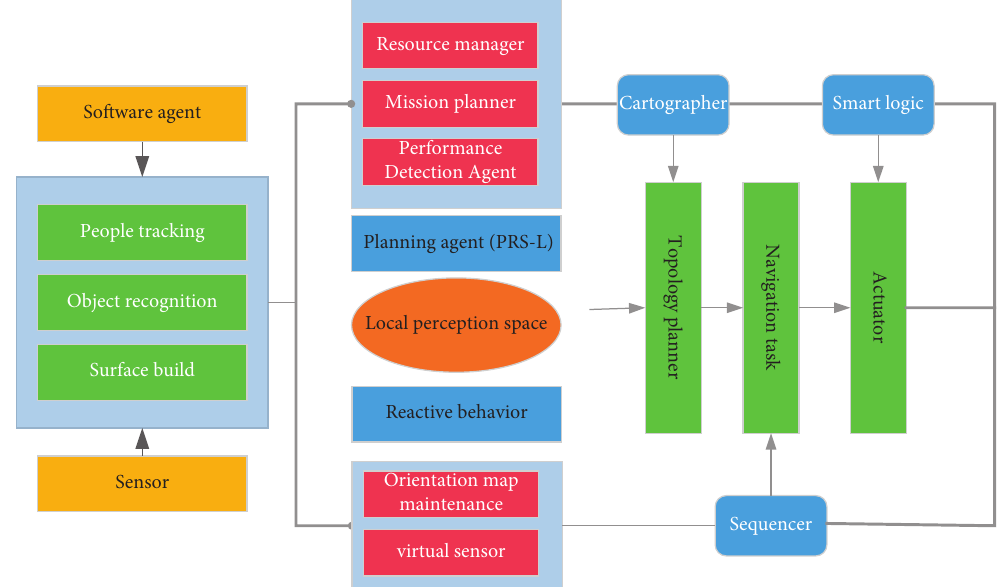
Figure 1: Intelligent obstacle avoidance system diagram.